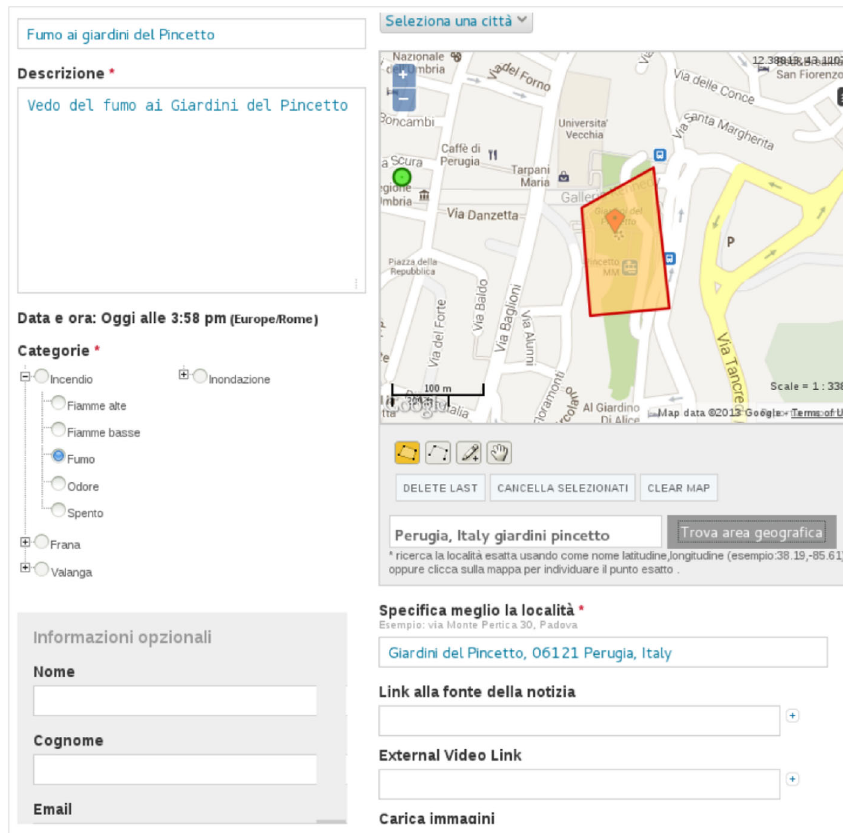
Fig. 3 Authorities, technicians, volunteers, and (registered/ unregistered) citizens can provide geo-localized information by filling out a simple form on their mobile device. In this case, a potential danger (smoke) at a public park is